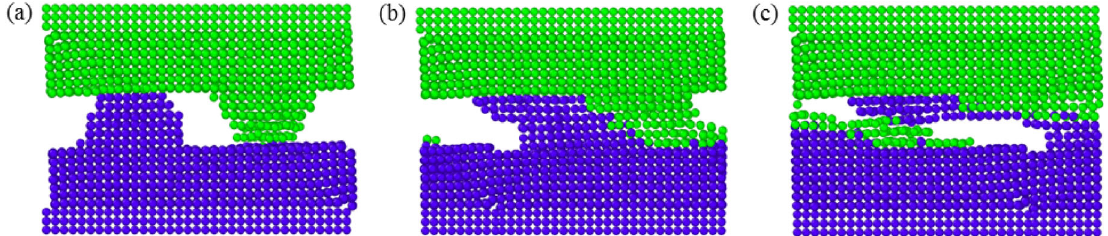
Fig. 2 Illustrations of Al–Al first friction contact during the fretting process: (a) the fretting process starts, (b) wear begins during the first friction contact, and (c) the first friction contact finishes and the interval